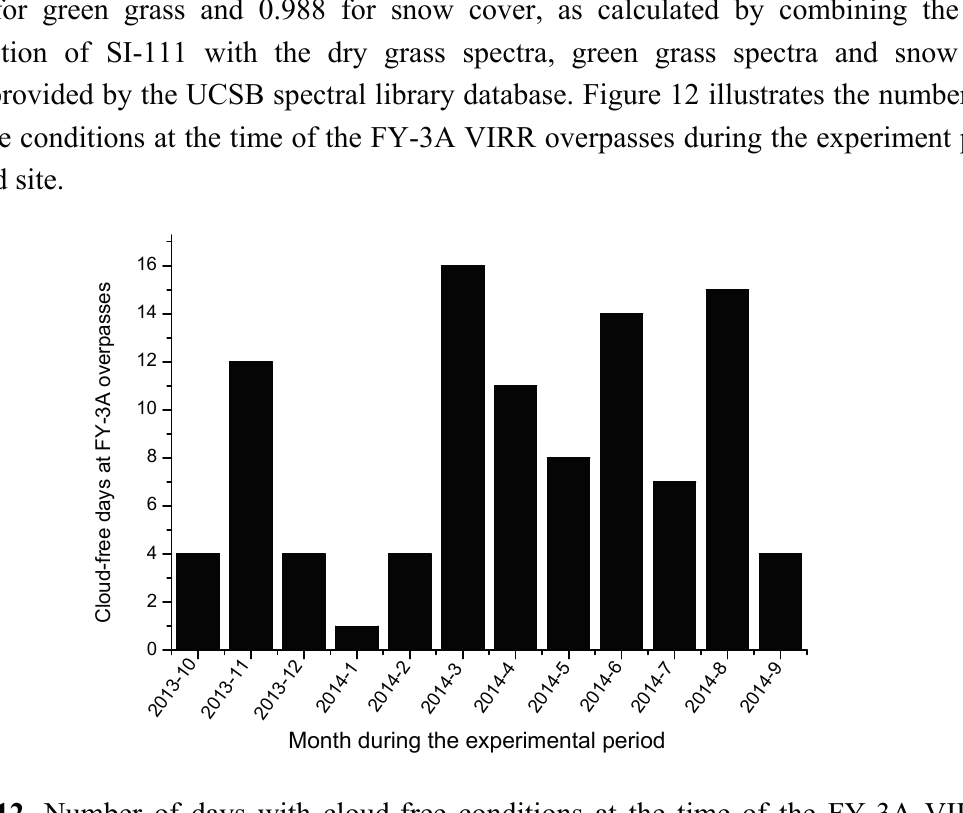
Figure 12. Number of days with cloud-free conditions at the time of the FY-3A VIRR overpasses during the experimental period at the study